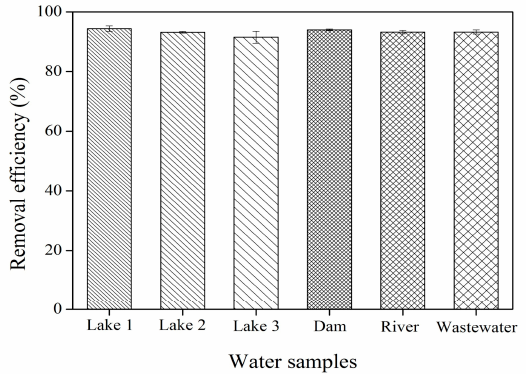
Figure 8. Removal of TC added in various environmental water samples at an initial concentration of 30 mg L − 1 .